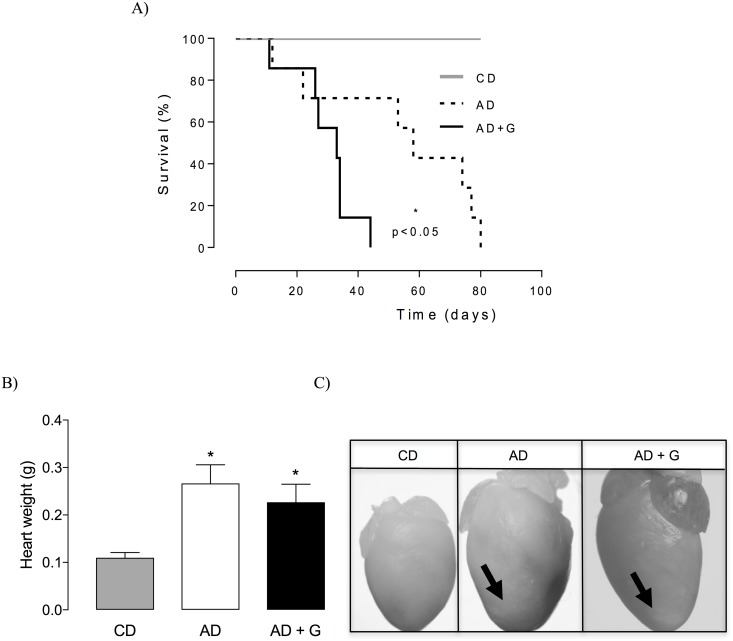
Effect of gugulipid on lifespan, heart size, and infarct scarring in atherogenic diet-fed male SR-BI KO/ApoER61h/h mice.(A) Kaplan-Meier survival curve, (B) heart weight, and (C) heart infarct scarring (arrows) in control, atherogenic diet-fed, and gugulipid-treated atherogenic diet-fed mice. CD: control diet; AD: atherogenic diet; AD+G: atherogenic diet supplemented with gugulipid. Two independent experimental sets were used; n = 6–8 mice in each group. Values represent mean ± SD. *P<0.05.